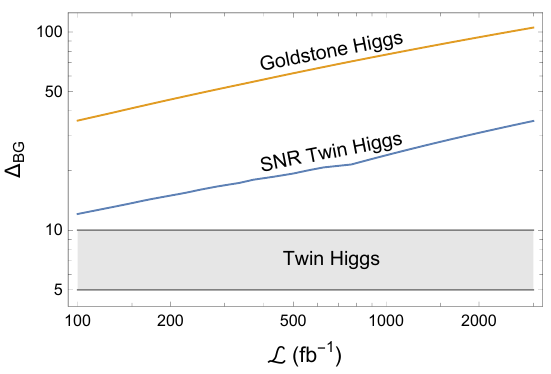
Figure 4 . Projected amount of fine tuning in case of non-observation of top partners and twin fermion partners at 14 TeV LHC for simple Goldstone Higgs, Twin Higgs with ˆ n fermions, and the vanilla Twin Higgs. Goldstone Higgs case bound can increase significantly if all top partners production channels are taken into